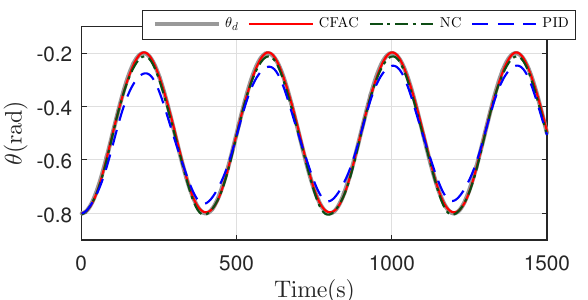
Figure 12. Pitch angle tracking performance in submerging motion with a constant velocity and variable pitch angle command.